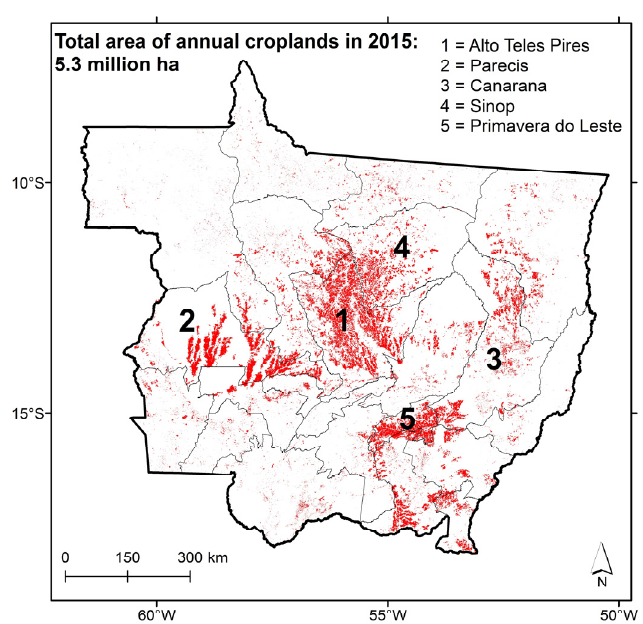
Figure 12. Map of annual croplands in Mato Grosso State, derived from the PROBA-V 100 m. Divisions in the map correspond to the microregions (regions that aggregate a varying number of municipalities with high levels of economic and social similarity). The five microregions highlighted in the map correspond to the microregions with the highest extents of annual croplands in 2015.